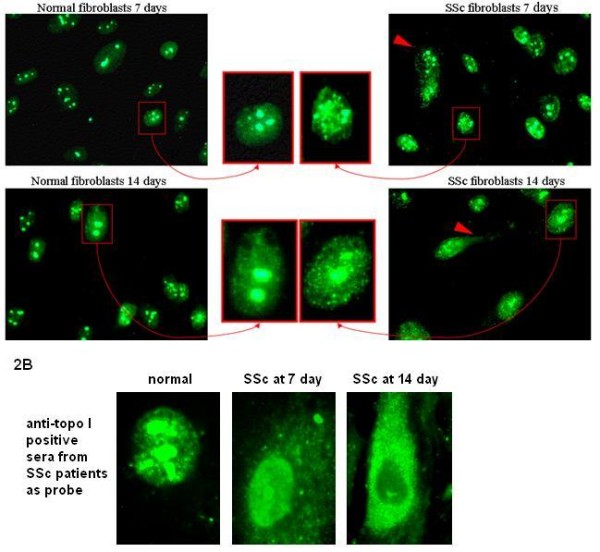
Comparison of topo I staining in cultured fibroblasts of normal controls and SSc patients. A. Topo I immunostaining with anti-topo I monoclonal antibodies showed multiple speckles in the nucleoplasm of SSc fibroblasts, which is differentiated from that in normal fibroblasts (relatively homogenous stain of topo I) at both 7 and 14 days of cultures. Some SSc fibroblasts show cytoplasmic staining of topo I protein (marked with red arrow heads). B. Topo I immunostaining with anti-topo I positive sera from SSc patients show the expected nuclear/nucleolar staining as well as cytoplasmic staining of SSc fibroblasts. At Day 14, the cytoplasmic staining appeared to increase relative to the nucleoplasm and nucleolar staining.